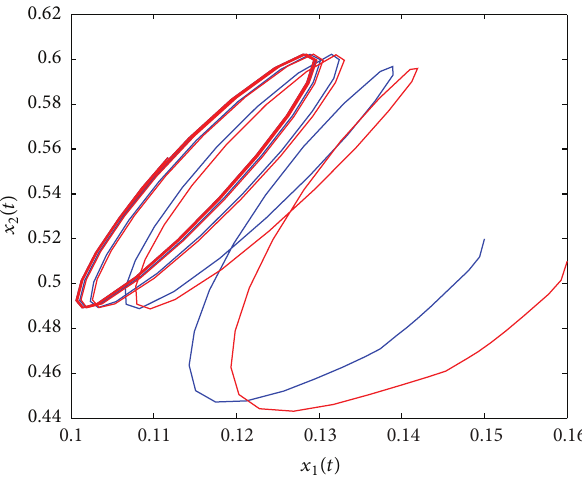
Figure 2: The unique positive 2𝜋 -periodic globally stable solution, which is plotted in the 𝑥 1 - 𝑥 2 plane. Two different initial solutions are included to show the attractivity of different solutions, which are plotted in red and blue color, respectively.